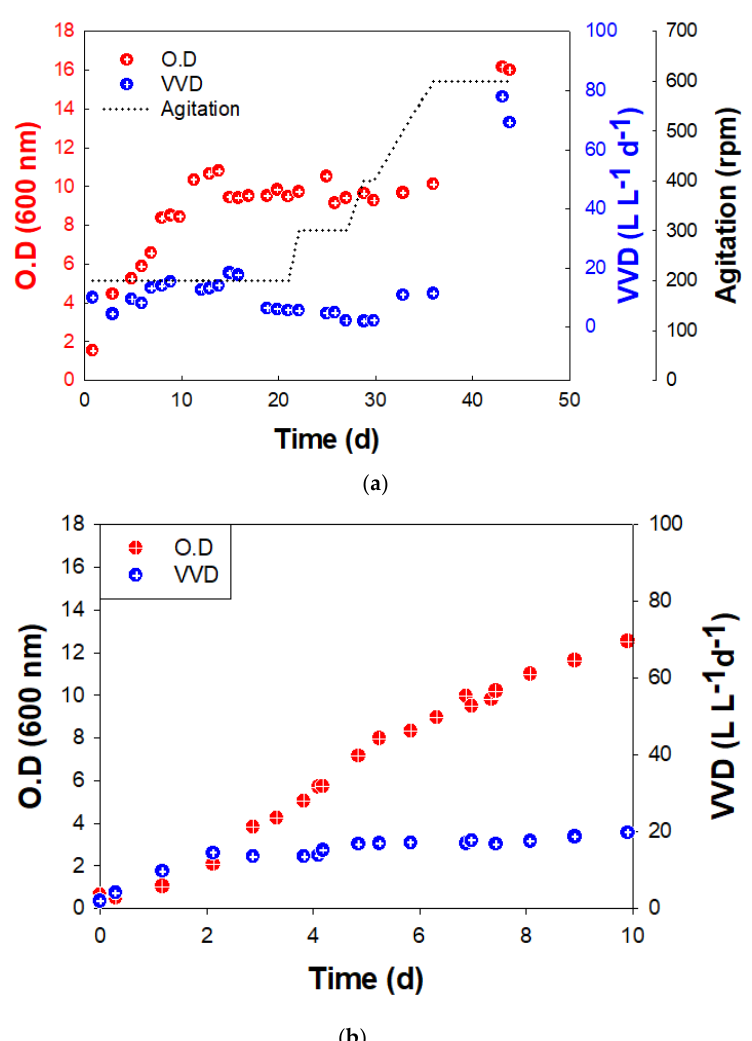
Figure 3. Growth (O.D.at 600 nm) and methane production rate (VVD) of BS-9 ( a ) in ST and ( b ) BC reactors.